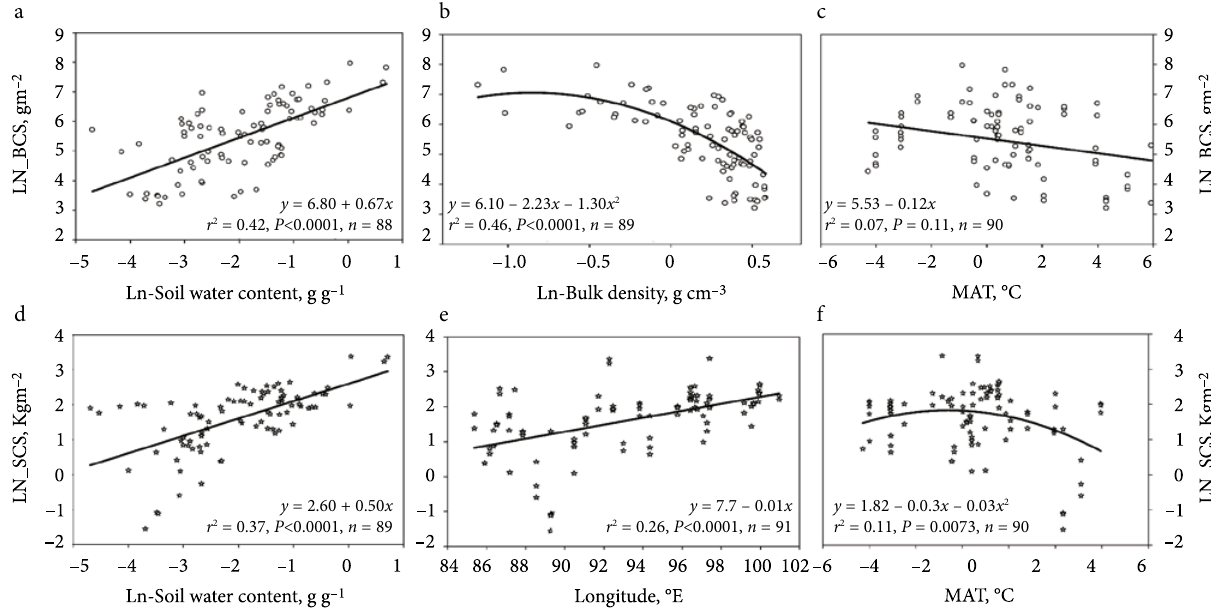
Fig. 3. Relationships of log-transformed belowground and soil carbon stock to environmental variables: (a) soil moisture; (b) soil bulk density; (c) mean annual temperature; (d) soil moisture; (e) longitude; (f) mean annual temperature. BCS is belowground carbon stock; SCS is soil carbon stock; MAT is mean annual